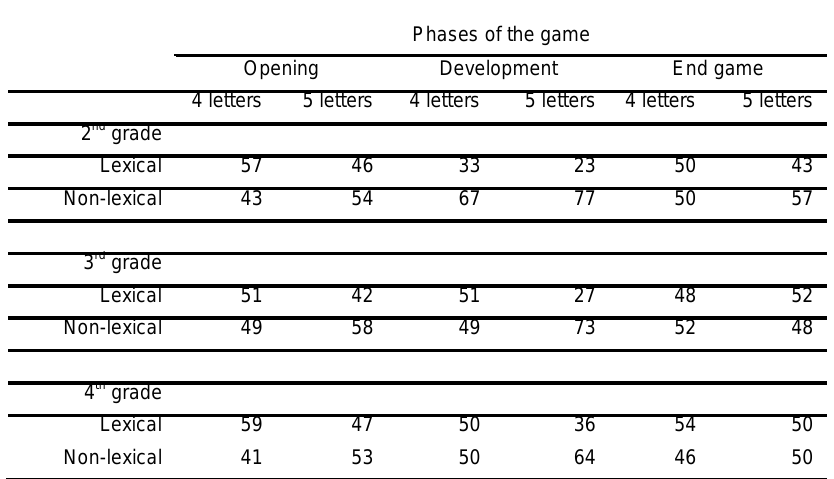
Table 2. Percentage of lexical and non-lexical strategies used by Brazilian children